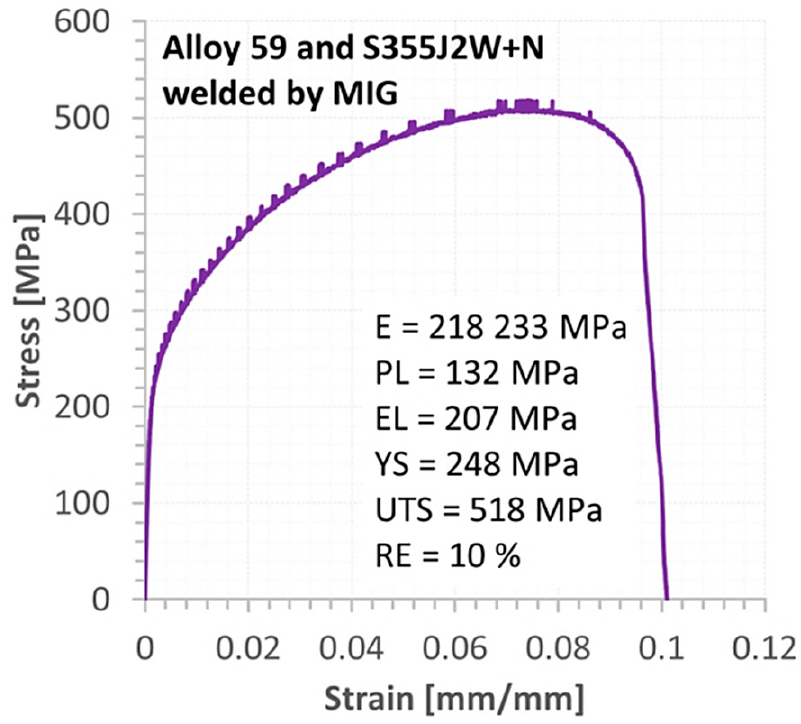
Figure 14. Tensile curve of the MIG weld for Alloy 59 and S355J2W+N steel.